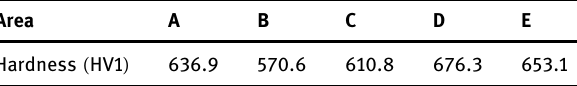
Table 5: The hardness of the electrolytic Ni – 37Re alloy coating measured at various points on the surface ( A, E – edge, C – center, B, D – points between the edge and the center )